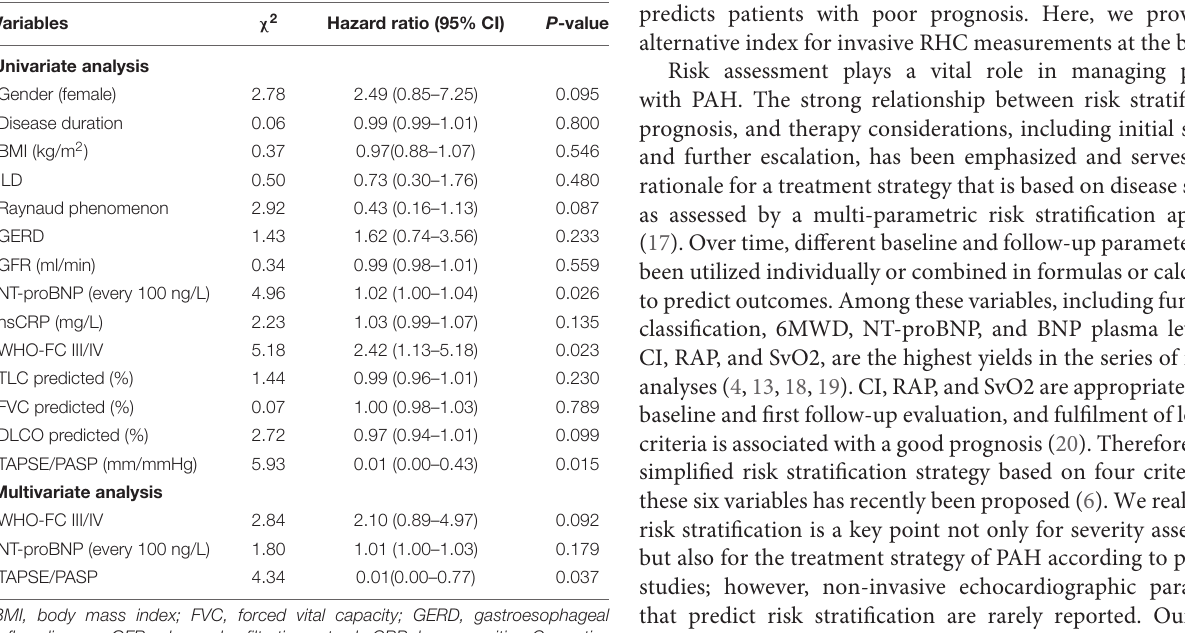
Frontiers in Cardiovascular Medicine |